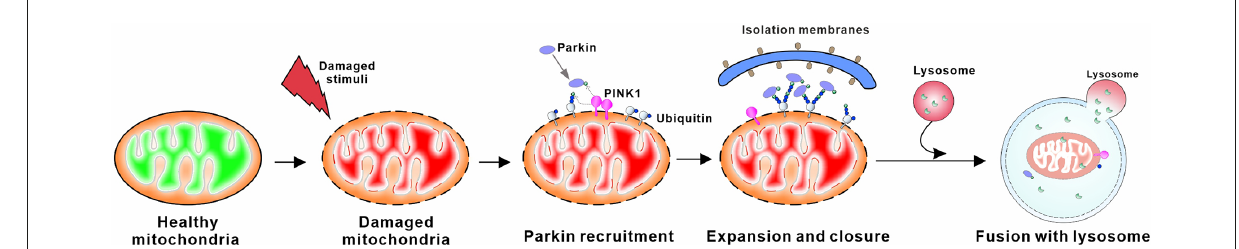
FIGURE4 Schematic overview of PINK1/Parkin mediated mitophagy. PINK1 accumulates at the surface of damaged mitochondria when the constitutive degradation of PINK in the mitochondrial matrix is inhibited. Subsequent homodimerization of PINK1 on the OMM leads to autophosphorylation, which promotes its activation. Activated PINK1 phosphorylates ubiquitin to recruit parkin, an E3 ubiquitin ligase, to the mitochondrial membrane. PINK1 regulates the localization and activity of parkin through phosphorylation of both ubiquitin and the ubiquitin-like domain of parkin. This process leads to ubiquitination of mitochondrial proteins on the OMM that can then be bound by autophagic proteins, ultimately triggering the formation of autophagosomes that deliver the damaged mitochondria to lysosomes for